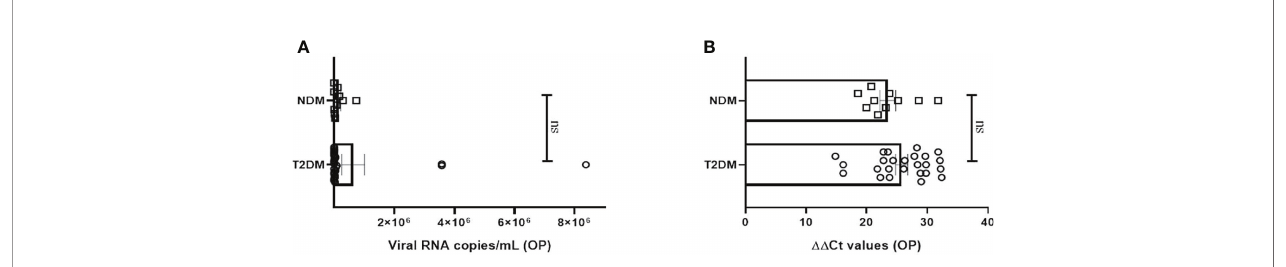
FIGURE 1 | Analysis of viral load in oropharyngeal samples in Covid-19 patients. (A) Bar diagram depicting the viral copy number of oropharyngeal (OP) samples collected from T2DM (n = 25) and NDM (n = 10) COVID-19 patients. (B) Bar diagram representing the DD CT of OP samples of NDM and T2DM COVID-19 patients. The Mann-Whitney (non-parametric, two tailed) test was performed. ns, not signi fi cant. All error bars were